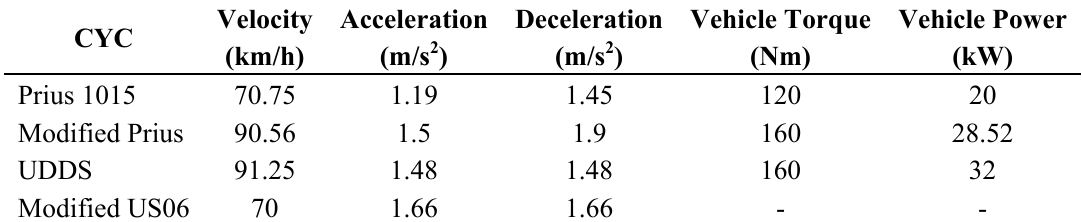
Table 3. Maximum specifications of the used driving cycles.